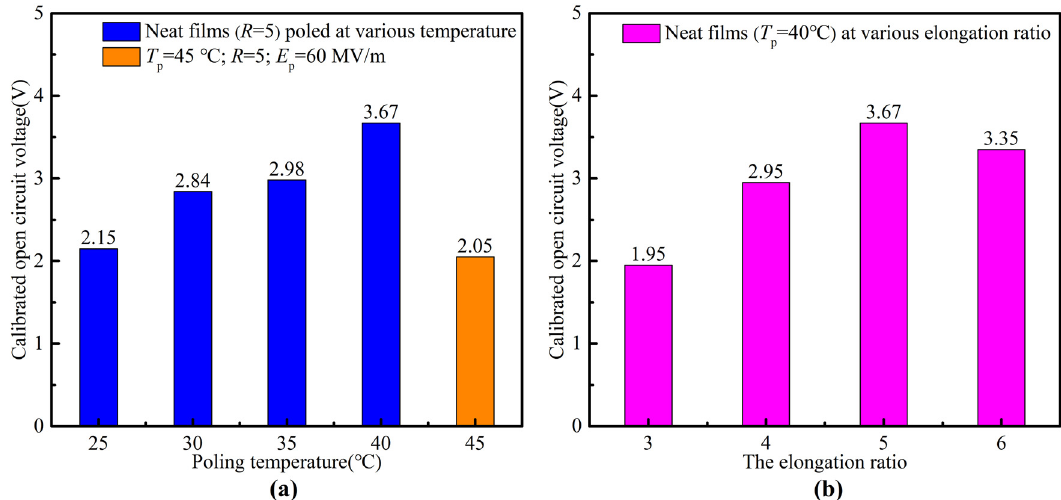
Figure 4: The calibrated open circuit output voltages of PVDF - HFP fi lms: ( a ) PVDF - HFP fi lms ( R = 5 ) poled at various temperatures; ( b ) PVDF - HFP fi lms ( T p = 40°C ) stretched at various elongation ratios.